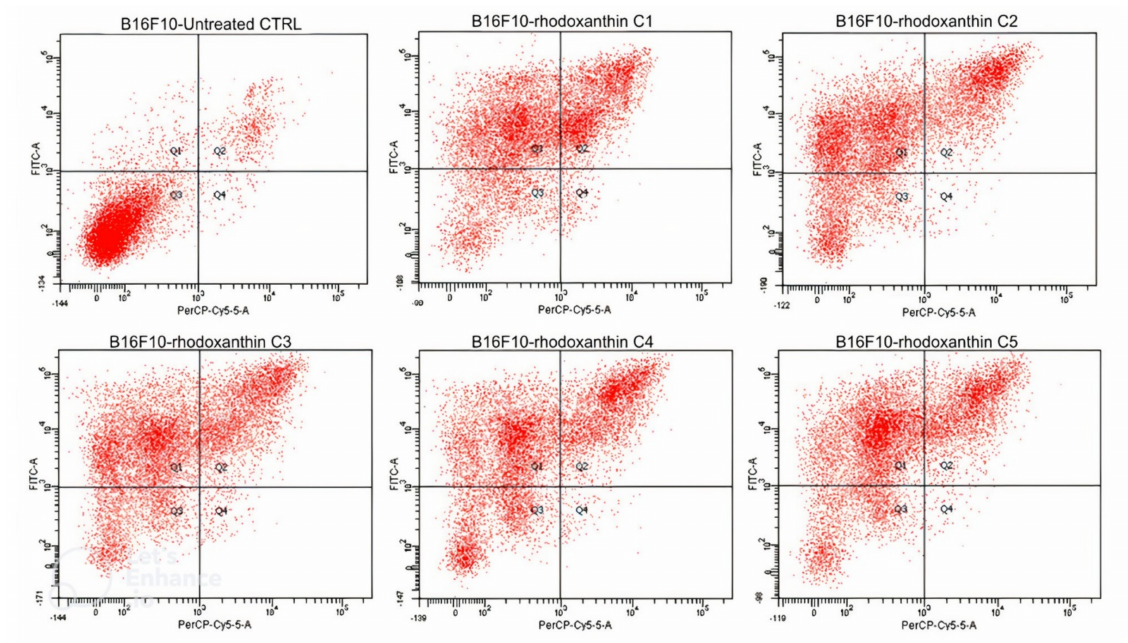
Figure 7. Analysis by flow cytometry of the viability of the B16F10 cell line treated with rhodoxanthin (Q1 = cells in early apoptosis, Q2 = cells in late apoptosis, Q3 = viable cells, and Q4 = necrotic cells). Values represent the mean ± SD of three samples (C1—0.18 µ mol/mL, C2—0.13 µ mol/mL, C3—0.077 µ mol/mL, C4—0.05 µ mol/mL, and C5—0.025 µ mol/mL